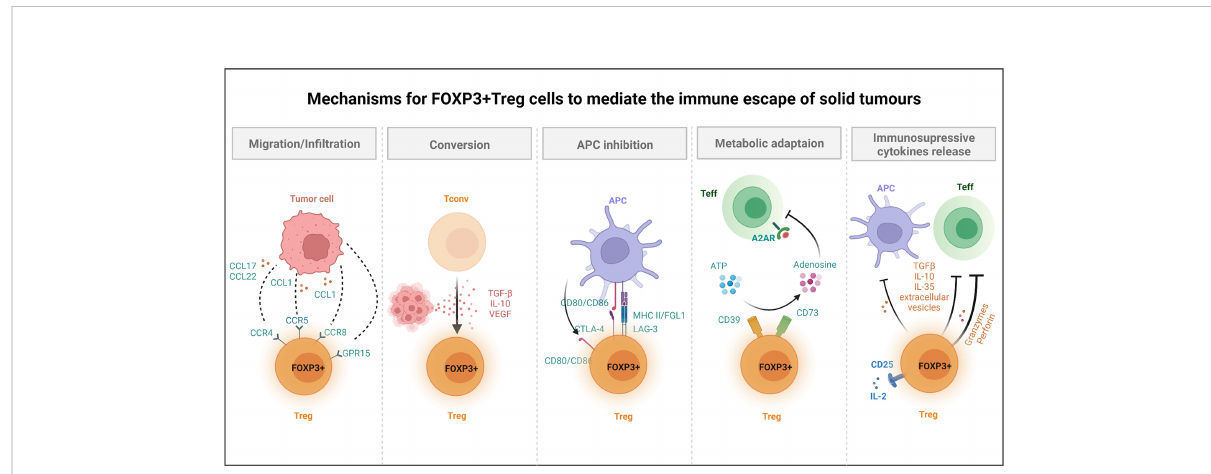
FIGURE 2 Mechanisms for FOXP3+ Treg cells to mediate the immune escape of solid tumours. Several mechanisms of Treg cells have been reported to help tumour to avoid immune destruction. For instance, Treg cells can promote the formation of immune suppressive microenvironment. Treg cells express chemokine receptors (e.g., CCR4, CCR8, CCR5, GPR15) and are recruited to the tumour site by chemokines produced by diverse cells within TME. Treg cells secreted immunosuppressive cytokines, TGF- b , and VEGF, which not only promote the conversion of Tconv cells to Treg cells, but also suppress Teff cells and APCs function. Treg cells constitutively express CTLA-4, while downregulate the expression of CD80/ CD86 in APCs (through trans-endocytosis), thereby depriving co-stimulatory signals to responder T cells. Meanwhile, Treg cells inhibit the function of DCs through LAG-3 and MHC II interactions. For metabolic adaptation, Treg cells could converse ATP to adenosine by CD39 and CD73, which directly inhibits A2AR mediated Teff cells function. Cells within TME could also be killed by Treg cells secreted granzyme and perforin. CCL, C-C motif chemokine ligand; CCR, C-C motif chemokine receptor; GPR, G protein-coupled receptor; Tconv, conventional CD4 T cell; TGF, transforming growth factor; IL, interleukin; VEGF, vascular endothelial growth factor; CTLA-4, cytotoxic T-lymphocyte associated protein 4; MHC, major histocompatibility complex; FGL1, fi brinogen like 1; Teff, effector T cell; A2AR, adenosine A2A receptor; LAG-3, lymphocyte activating